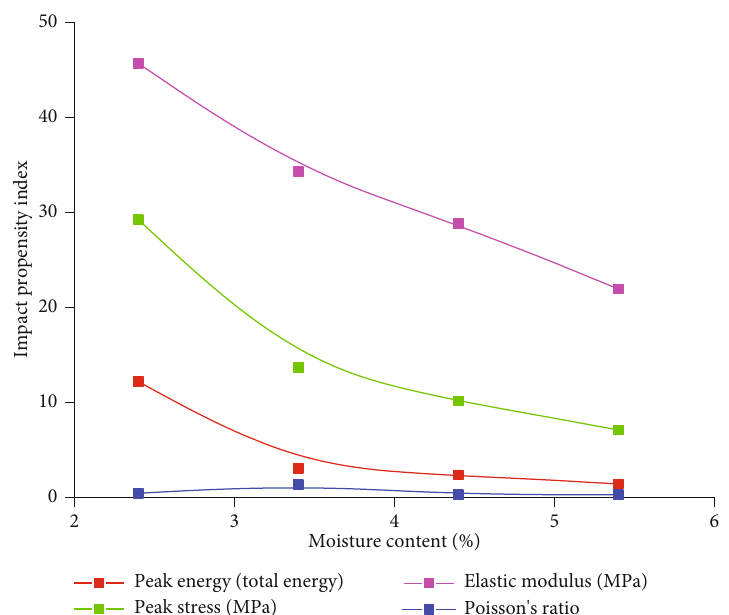
Figure 10: Bursting liability index diagram of coal samples with di ff erent water content.